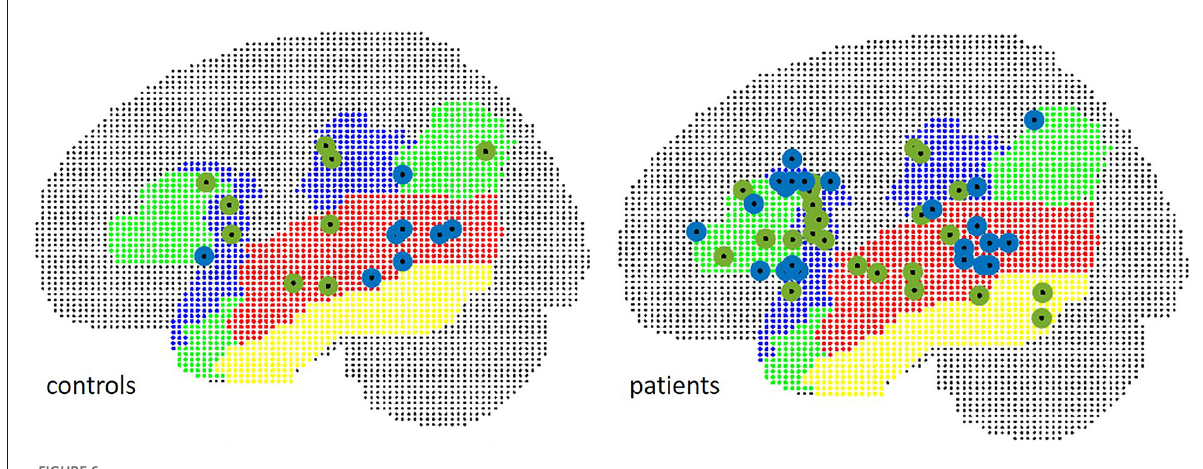
FIGURE6 Localization of peak t -values in MEG (green) and fMRI (blue), separate for patients (right) and controls (left).